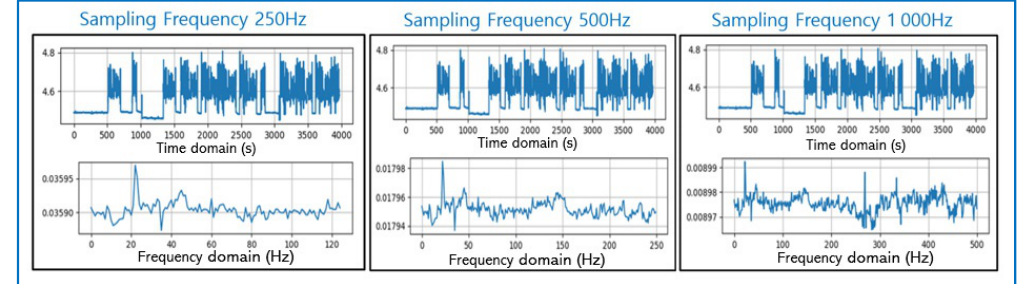
14 of 18 Figure 13. Train loss by CNN-LSTM algorithm after FFT at 100 Hz frequency.